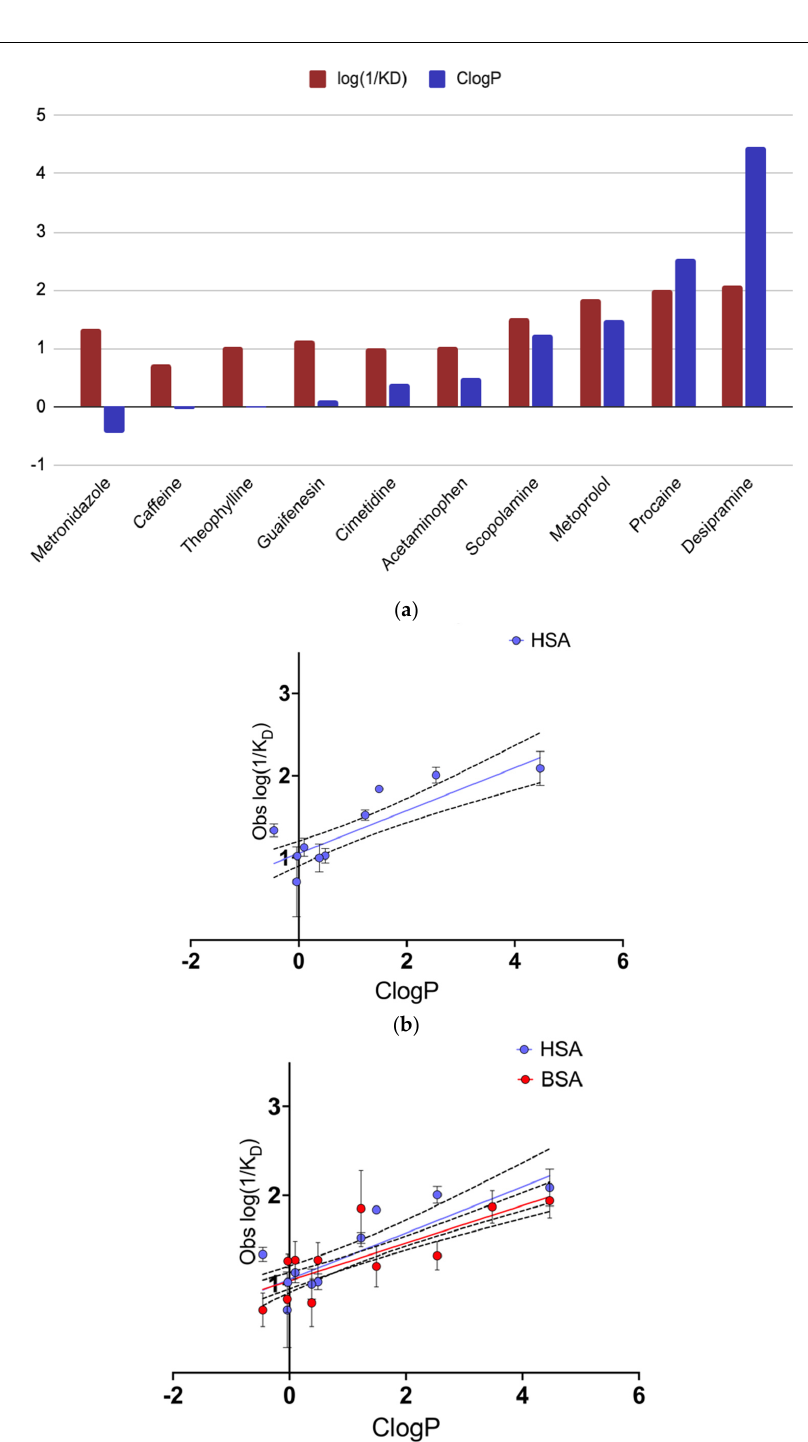
Figure 2. Binding of drugs with varying hydrophobicity to HSA, as measured using QCM-D. ( a ) Red bars represent the logarithm reciprocal binding constants (log(1/K D )) and blue bars represent hydrophobicity (ClogP) of each drug. ( b ) QSAR analysis for relationship of hydrophobicity (ClogP) to HSA binding strength (log 1/K D ) over all of the the tested ligands. Blue line represents a linear fit to the data, with a slope of 0.2607 ± 0.03888. ( c ) Prior QSAR analysis of BSA (red line) overlaid on HSA data with their corresponding